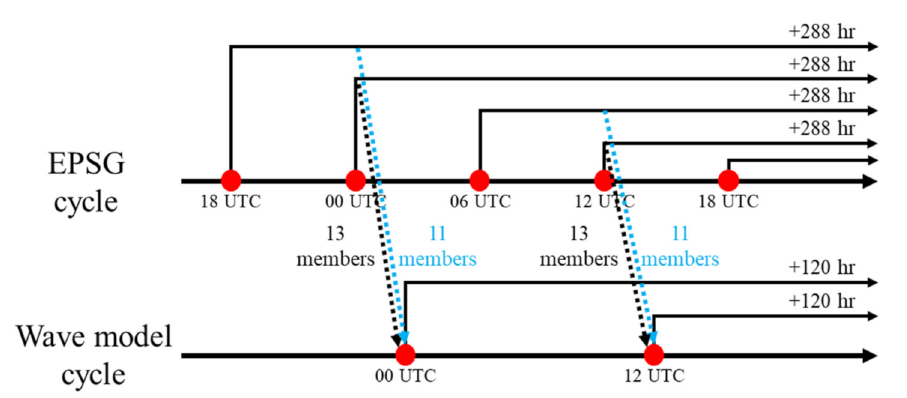
Figure 2. Operation diagram of forecast system for EPSG and ensemble wave model (EPSG 24 ensemble members sea winds consist of 13 members with control member at same time of wave model runs (00 UTC, 12 UTC) and 11 members performed 6 h prior to wave model runs (18 UTC, 06 UTC)).